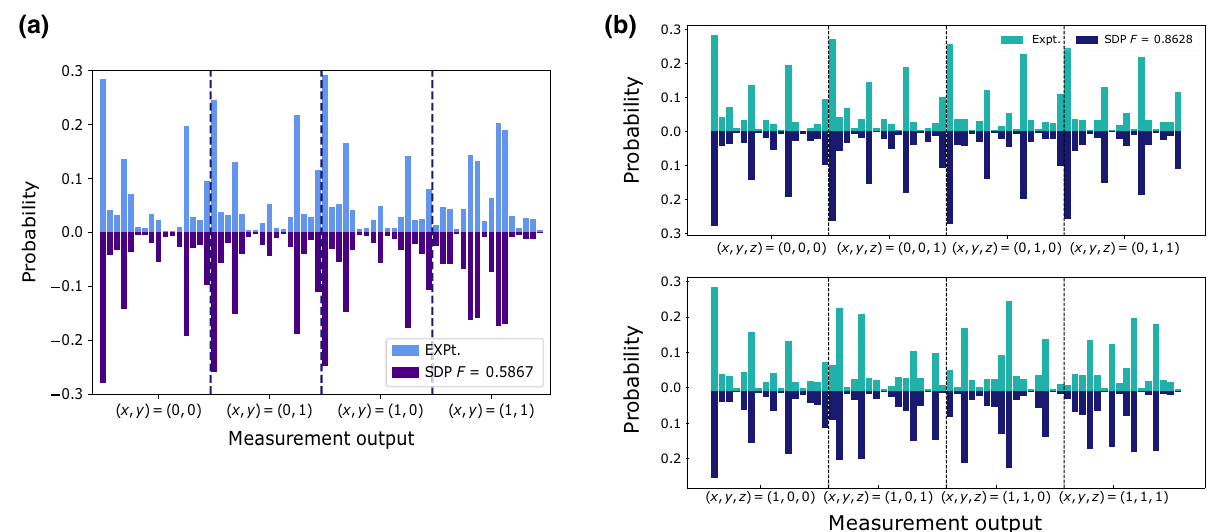
FIG. 3. Certifiable fidelities in parallel self-testing and tripartite scenarios (dual method). In the histograms shown , the upper bars correspond to the experimental frequencies of each measurement output, while the lower ones correspond to the probabilities given as a solution by the SDP optimization, with the experimental dual inequality imposed as a constraint. On the x axis, frequencies/probabilities are ordered in blocks that correspond to the possible choices of operators. (a) Parallel self-testing scenario. Indigo columns represent the experimental probabilities, divided in blocks that correspond to eight different sets of operators x and y , respectively, for Alice and Bob. Every block contains 16 columns, each corresponding to a different set of outcomes: ( a , b ) = ( 0, 0 ) , ( 0, 1 ) , ( 0, 2 ) , ( 0, 3 ) , ( 1, 0 ) , . . . , with a = 0, 1, 2, 3 and b = 0, 1, 2, 3. Purple columns represent the probabilities found by the SDP, with the experimental dual inequality imposed as a constraint, and corresponding to the computed bound for the fidelity F = 0.5867 ± 0.053 (the uncertainty is evaluated through Monte Carlo simulations). This result is obtained by optimization over the NPA set Q 3 (for further details see Appendix A). (b) Three-party case. Turquoise columns represent the experimental probabilities obtained by gathering all our data sockets, divided in blocks that correspond to eight different sets of operators x , y , and z , respectively, for Alice, Bob, and Charlie. Every block contains 16 columns, each corresponding to a different set of outcomes: ( a , b , c ) = ( 0, 0, 0 ) , ( 0, 0, 1 ) , ( 0, 1, 0 ) , ( 0, 1, 1 ) , ( 1, 0, 0 ) , . . . , with a = 0, 1, 2, 3 and b , c = 0, 1. Blue columns represent the probabilities found by the SDP, with the experimental dual inequality imposed as a constraint, and corresponding to the computed bound for the fidelity F = 0.8628 ± 0.032 (analogously, uncertainty is estimated through Monte Carlo simulations). In this case, the optimization is done over the NPA set Q 3 plus extramonomials of higher order (for further details see Appendix A. Both reported fidelity lower bounds are compatible, within statistical uncertainty, with those predicted considering the noise parameters that best model the states generated by our sources (for details about the noise model see Appendix D), amounting to F = 0.631 for the parallel case and F = 0.830 for the three-party